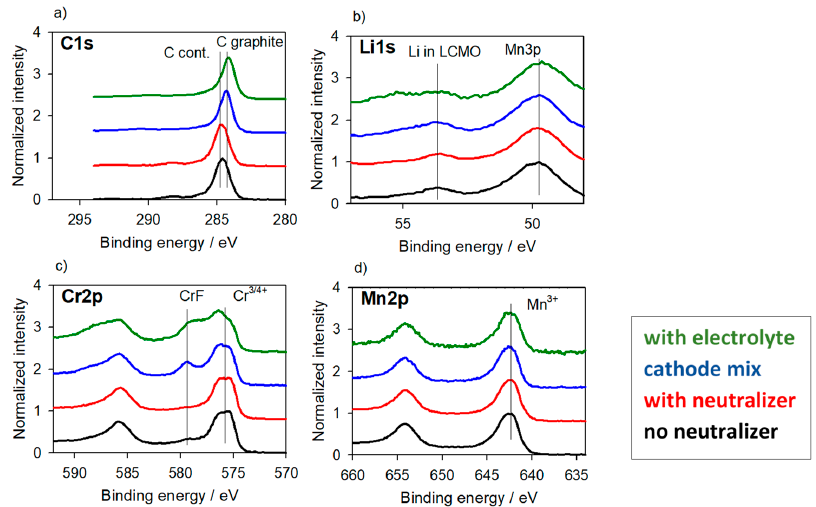
Figure 6. XP spectra normalized in intensity of pure LiCrMnO 4 powder measured without and with neutralizer, and cathode mix (LiCrMnO 4 , carbon black, binder) without and with contact to electrolyte ( bottom to top ). Here no charging was observed and no BE correction was necessary. C1s shows the peak shift between contamination and carbon black. Cr is found in the mixed state Cr 3+ / 4+ and reacts with binder and electrolyte; Mn is not taking part in reaction. ( a ) C1s; ( b ) Li1s; ( c ) Cr2p; ( d ) Mn2p transition.